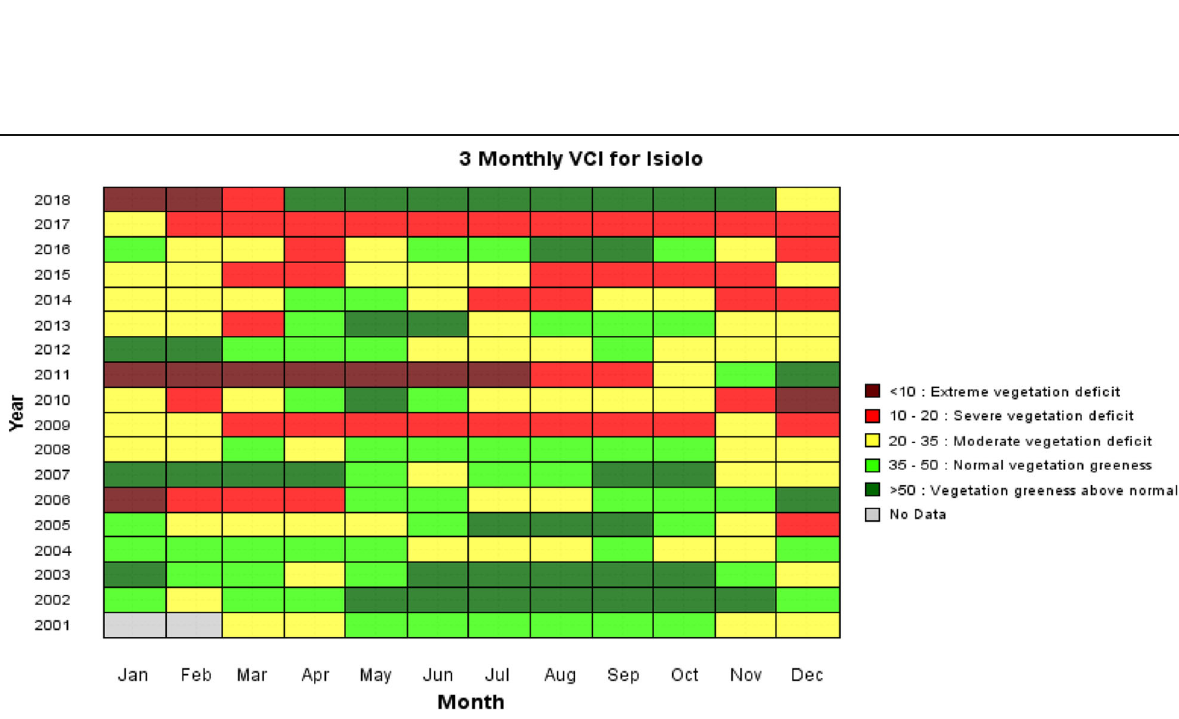
Fig. 2 A matrix of the quarterly vegetation condition index for Isiolo County. Source: NDMA